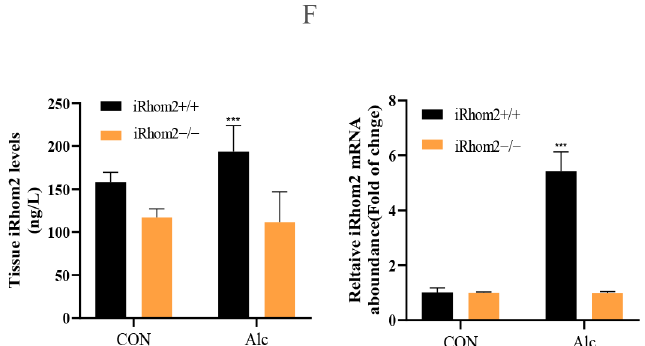
Figure 4. The iRhom2 gene reduces alcohol-induced inflammation: ( A ) TACE levels measured with IF and qPCR; ( B ) the presence of IL-1 β , IL-6, IL-18, TNF- α , TNFR1, and TNFR2 in tissue, calculated with ELISA; ( C ) IL-6, IL-18, IL-1 β , and TNF- α in liver tissue, calculated with qPCR; ( D ) expression of p-NF- κ B in liver tissue, analyzed with IF; ( E ) WB analysis of p-NF- κ B in liver tissue; ( F ) iRhom2 levels in mouse livers, analyzed with qPCR and ELISA. The data are expressed as the mean value ± SD ( n = 6). * p < 0.05 and *** p < 0.001 vs. the iRhom2+/+/CON group.